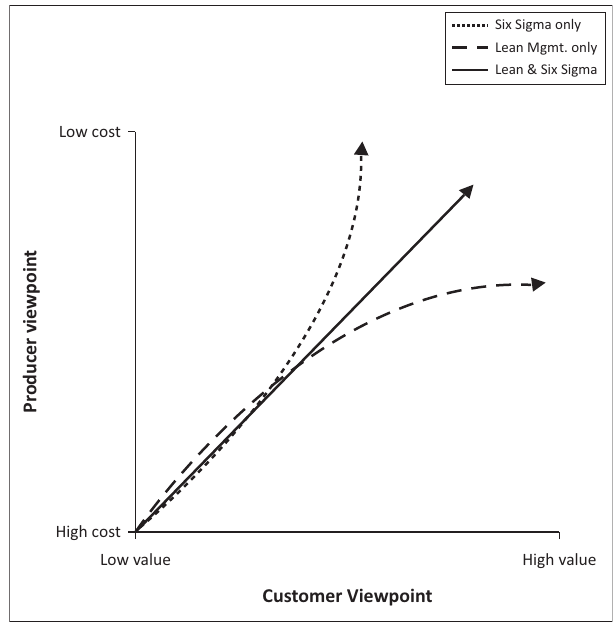
FIGURE 1: Nature of competitive advantage